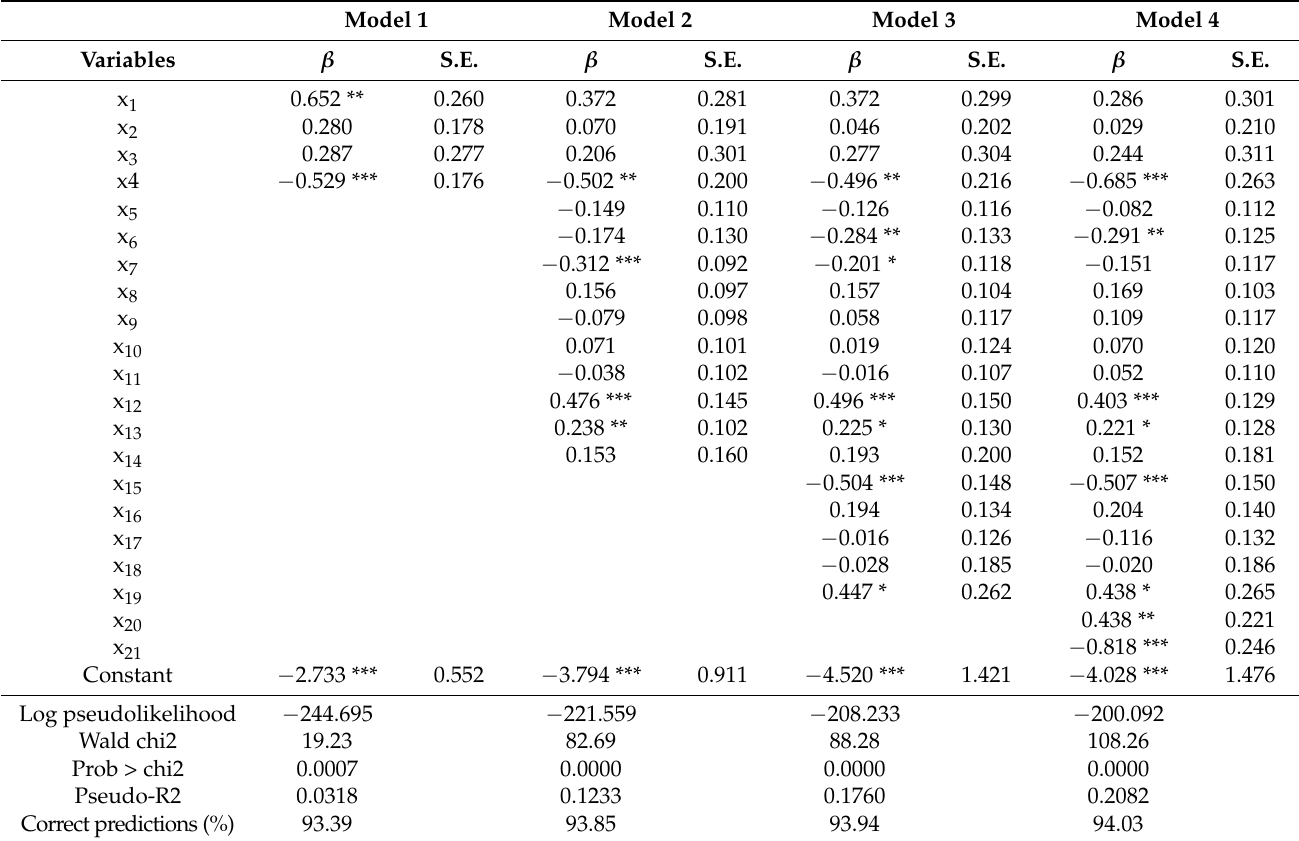
Table 7. Logistic regression for new-to-the-market product innovation (y 1 ). Model 1 Model 2 Model 3